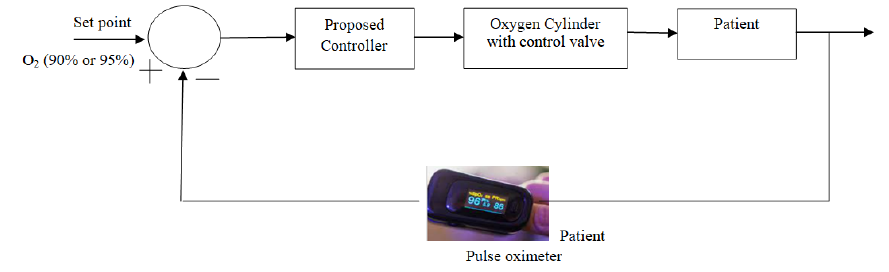
Figure 1. Basic block diagram of the proposed